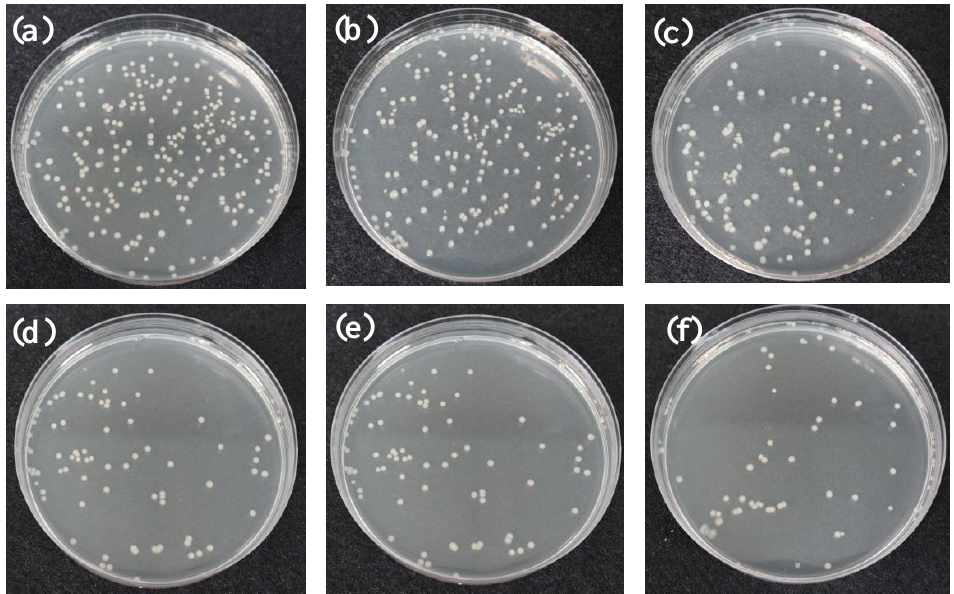
Figure 7. Colony count of functional antibacterial knitted fabrics made of 2-plied twisted yarns: ( a ) 2Zn-0C-K, ( b ) 2Zn-1C-K, ( c ) 2Zn-2C-K, ( d ) 2Zn-3C-K, ( e ) 2Zn-4C-K, and ( f ) 2Zn-5C-K.